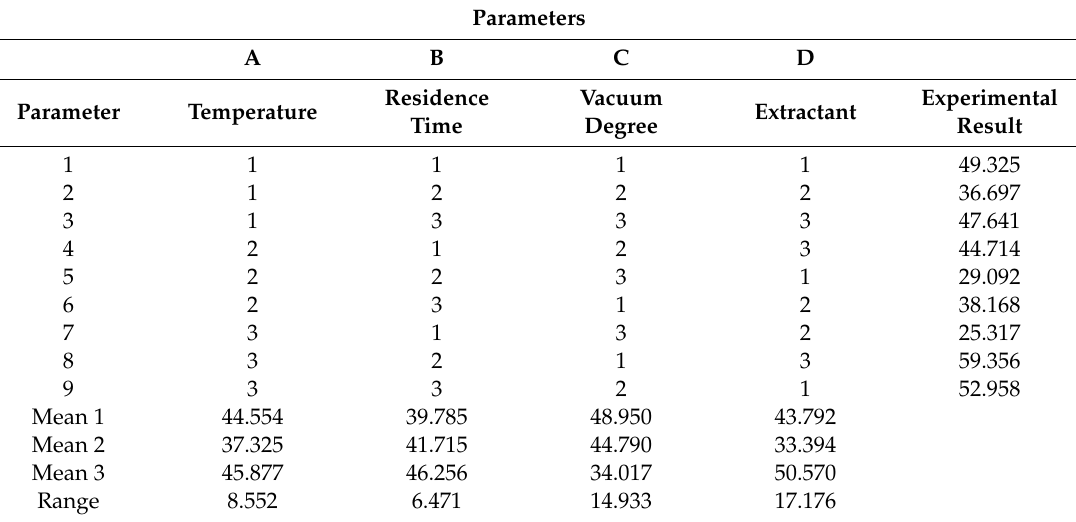
Table 4. Process orthogonal test analysis results.